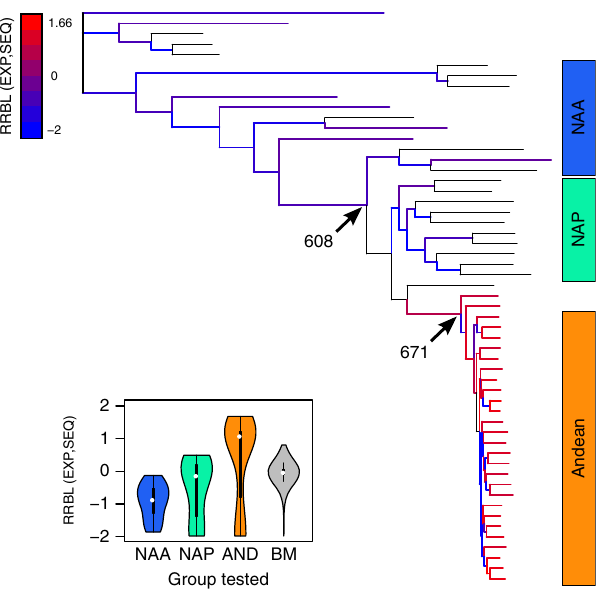
Figure 3 | Evolution of gene expression in New World lupins. Branches are coloured according to the relative contribution of gene expression and sequence divergence (measured with RRBL): high values indicate increased divergence in gene expression values. Branches with RRBL values within the 2.5th and 97.5th percentiles of the simulated distribution under BM (no selection on gene expression) are coloured black. Inset graph shows the distribution of RRBL values per branch in the different lineages (NAA; NAP; and Andean clade) and for data simulated under a Brownian motion model (that is, without selection on gene expression values, denoted BM). Black arrows indicate the two nodes with the highest number of shifts in optimal expression values of individual genes (number of genes preferring shift at each node are indicated), based on analysis of selection using Ornstein– Uhlenbeck